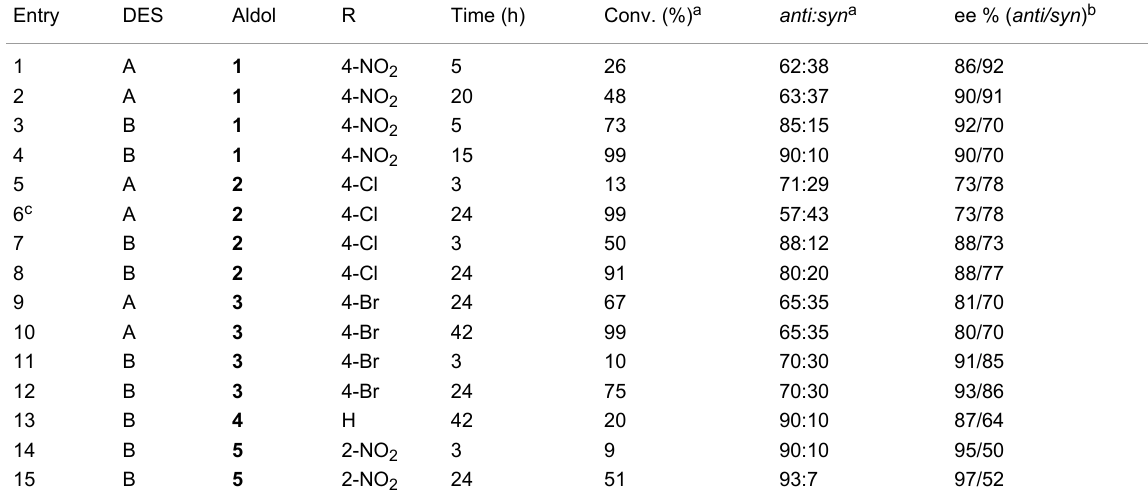
Table 4: In continuo aldol reactions of different aldehydes in DES A and DES B.